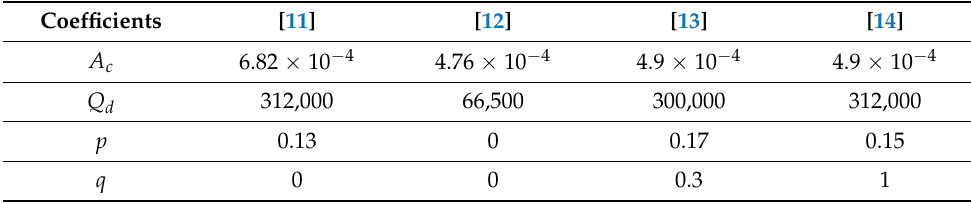
Table 1. Parameters used in the critical strain definition for carbon–manganese steel in [11,12,14] and low carbon steel in [13].